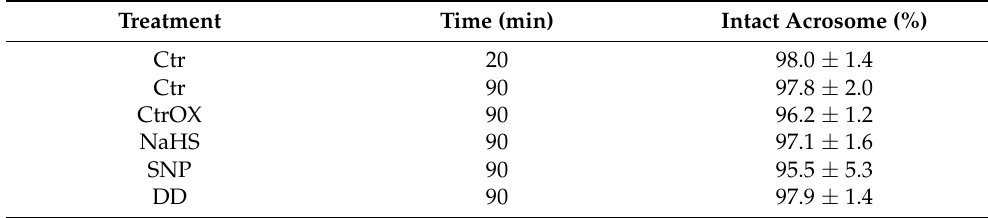
100 nM + NaHS 100 nM. Data are shown as mean ± SD of 6 replicates.